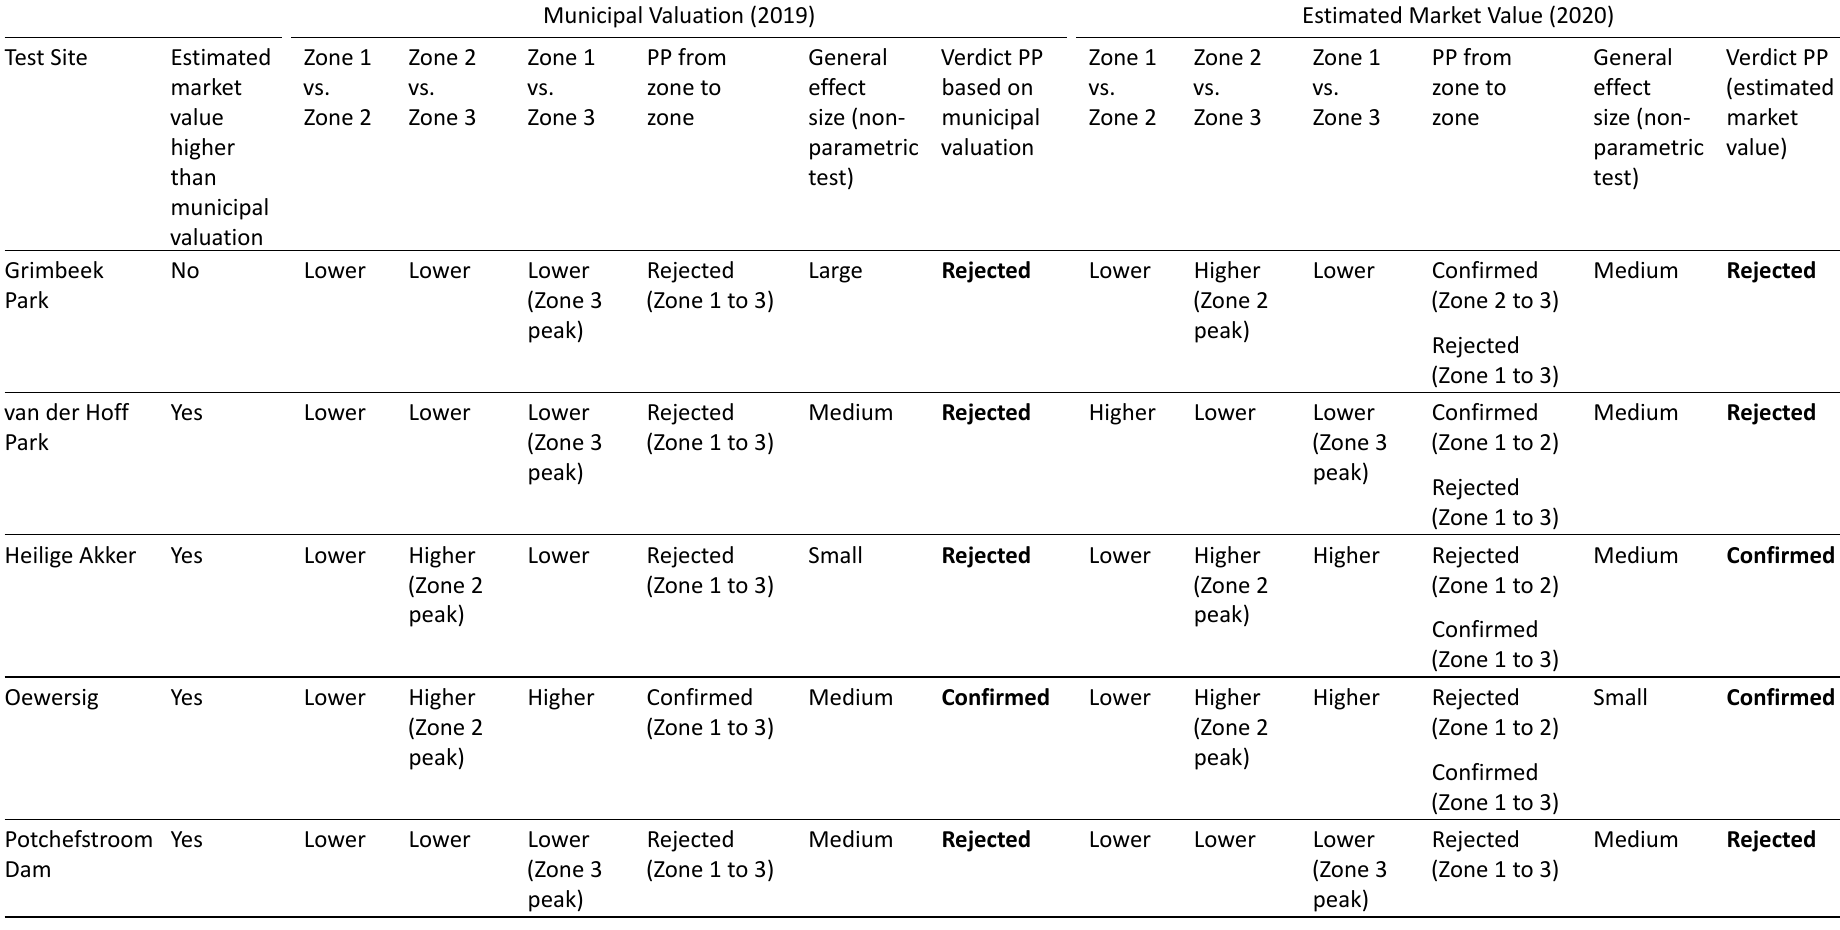
Table 5. Comparative summary of